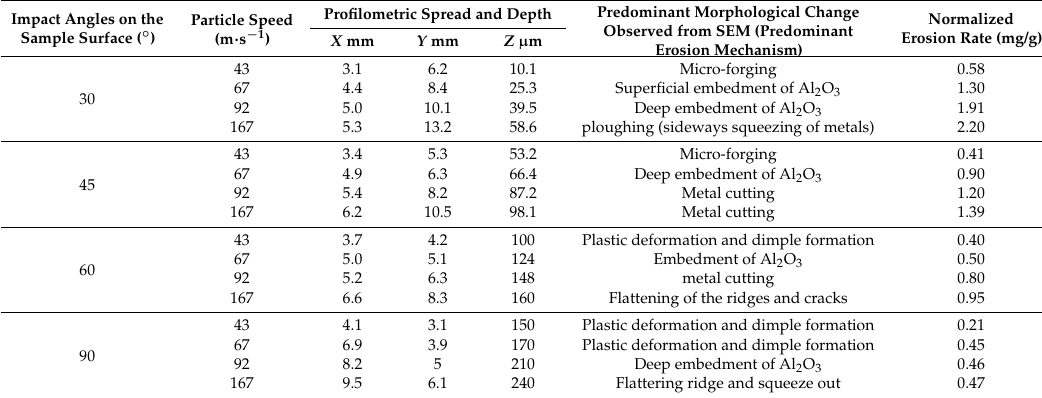
Table 2. The effect of changing the impact angle and the particle speed on the morphology and the erosion rate of API X120